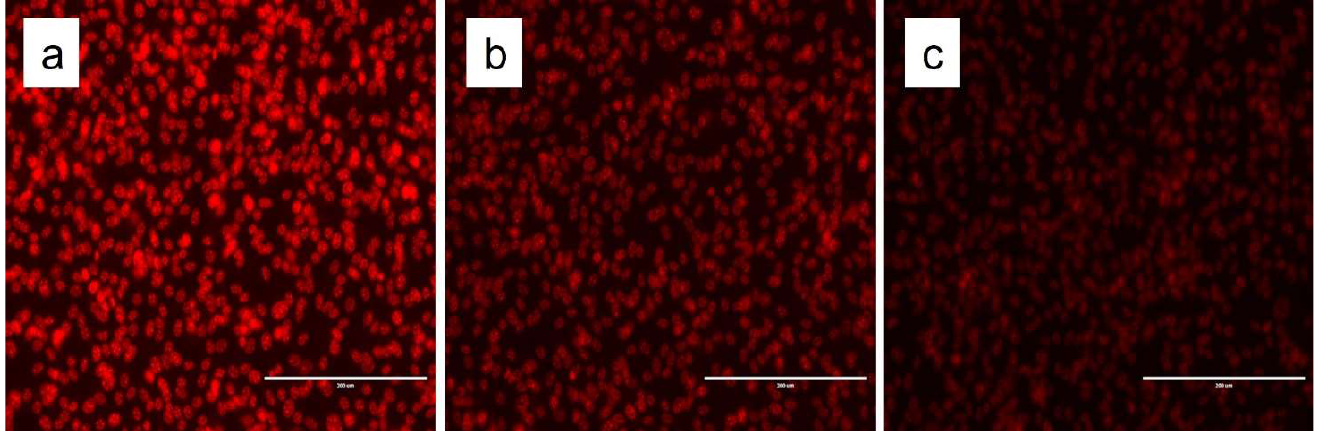
Figure 5. Fluorescence microscopy showing CL enhanced DNR uptake from liposomes F1 ( a ), F2 ( b ), free DNR ( c ).